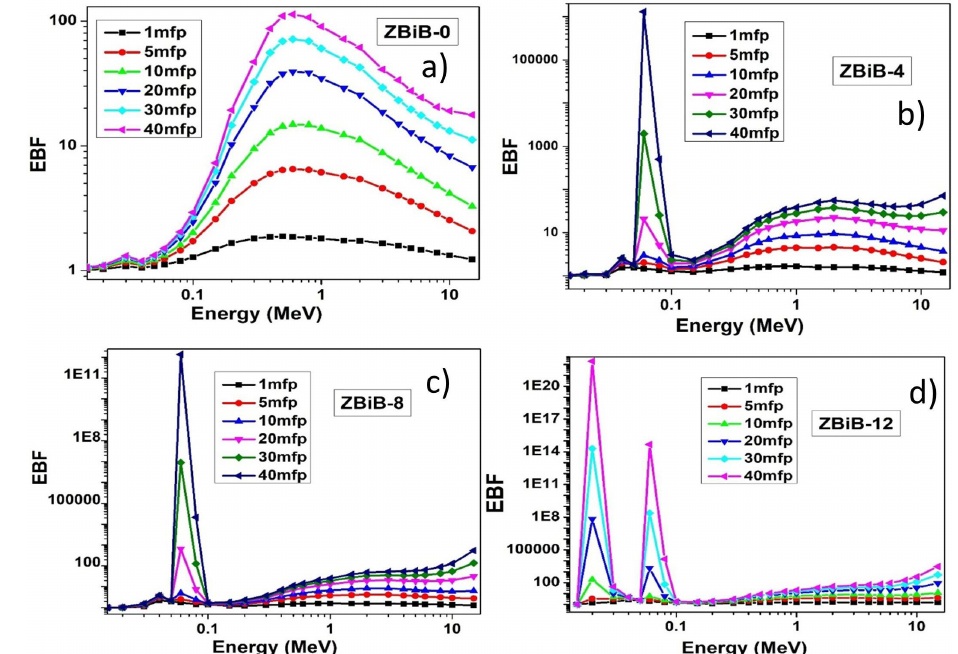
Figure 6. Variation of EBF of the selected glass samples with the gamma energy at different mfps in the range of 0.015-15MeV.